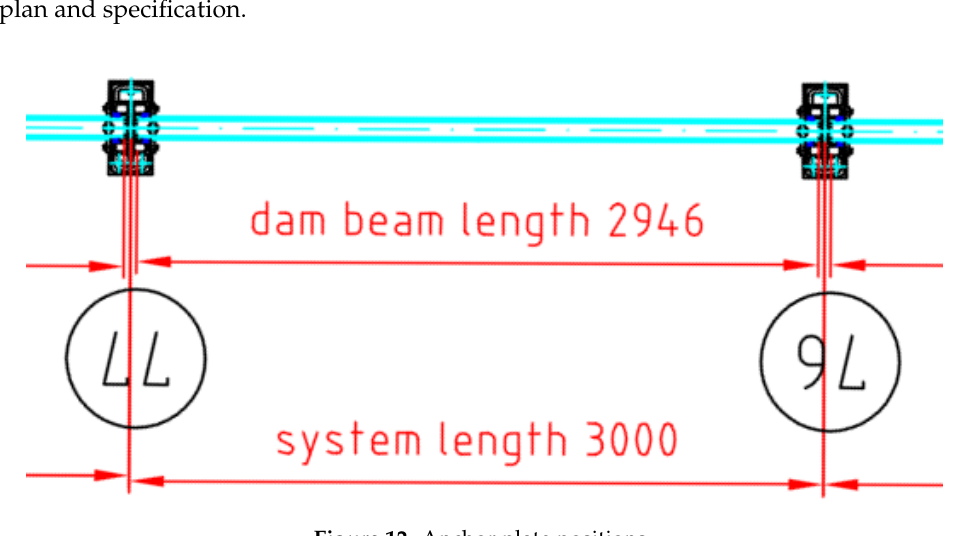
Figure 12. Anchor plate positions.